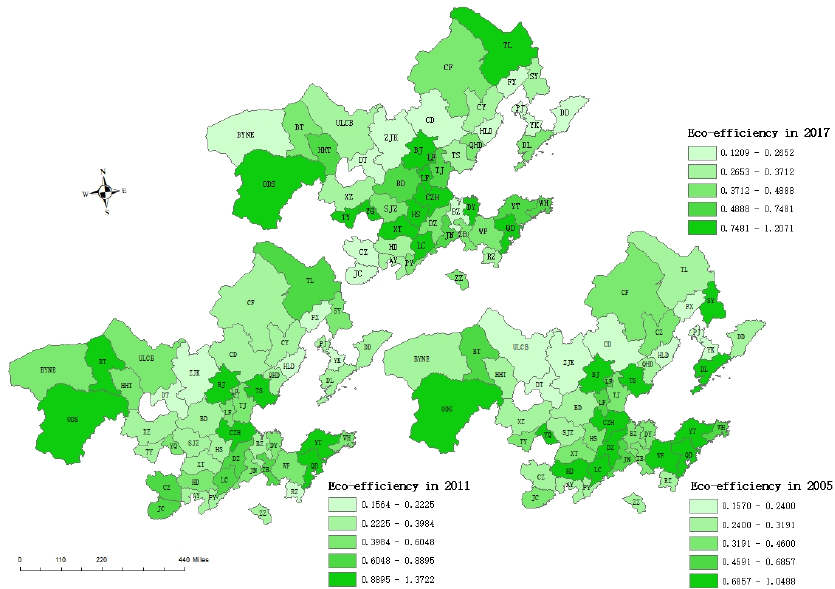
Figure 1. Distribution of eco ‐ efficiency inside Bohai Rim in 2005, 2011, and